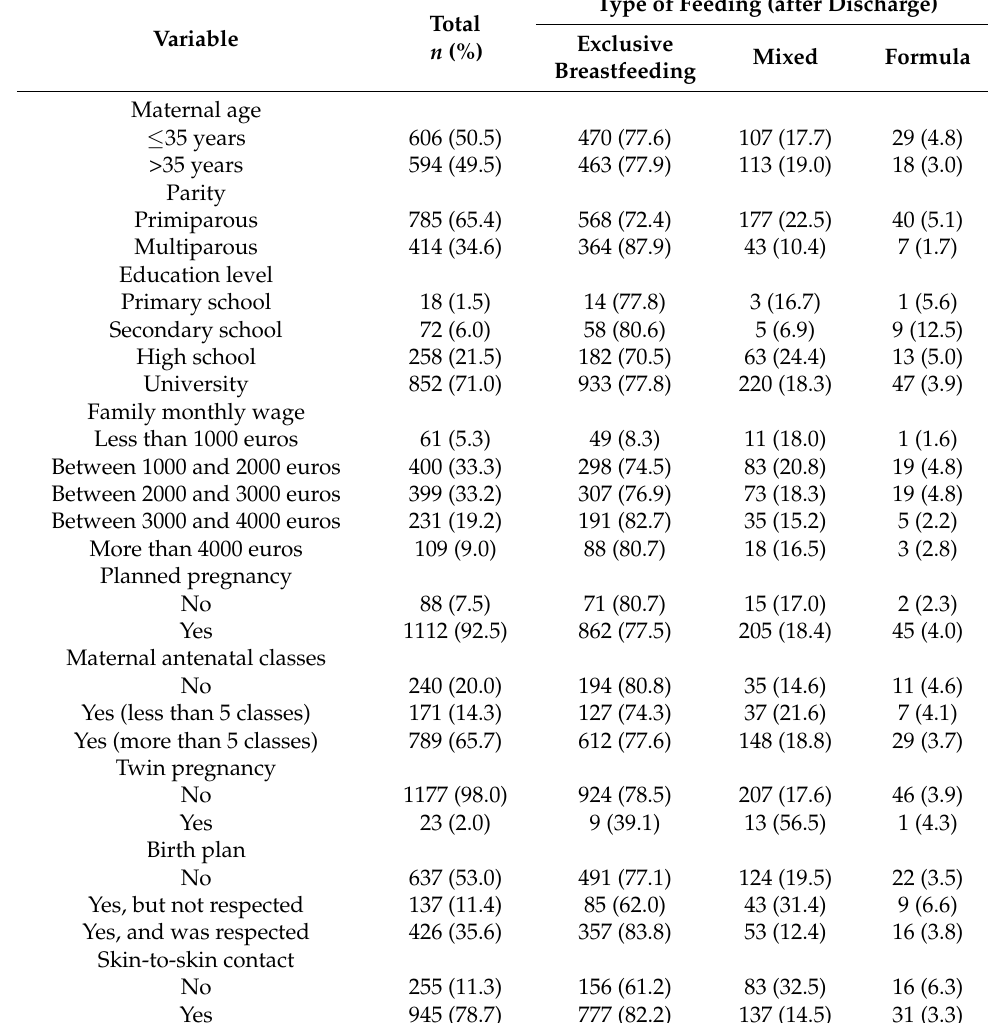
Table 1. Sociodemographic and obstetric characteristics of the sample and the type of breastfeeding after hospital discharge. Type of Feeding (after Total Variable n (%)